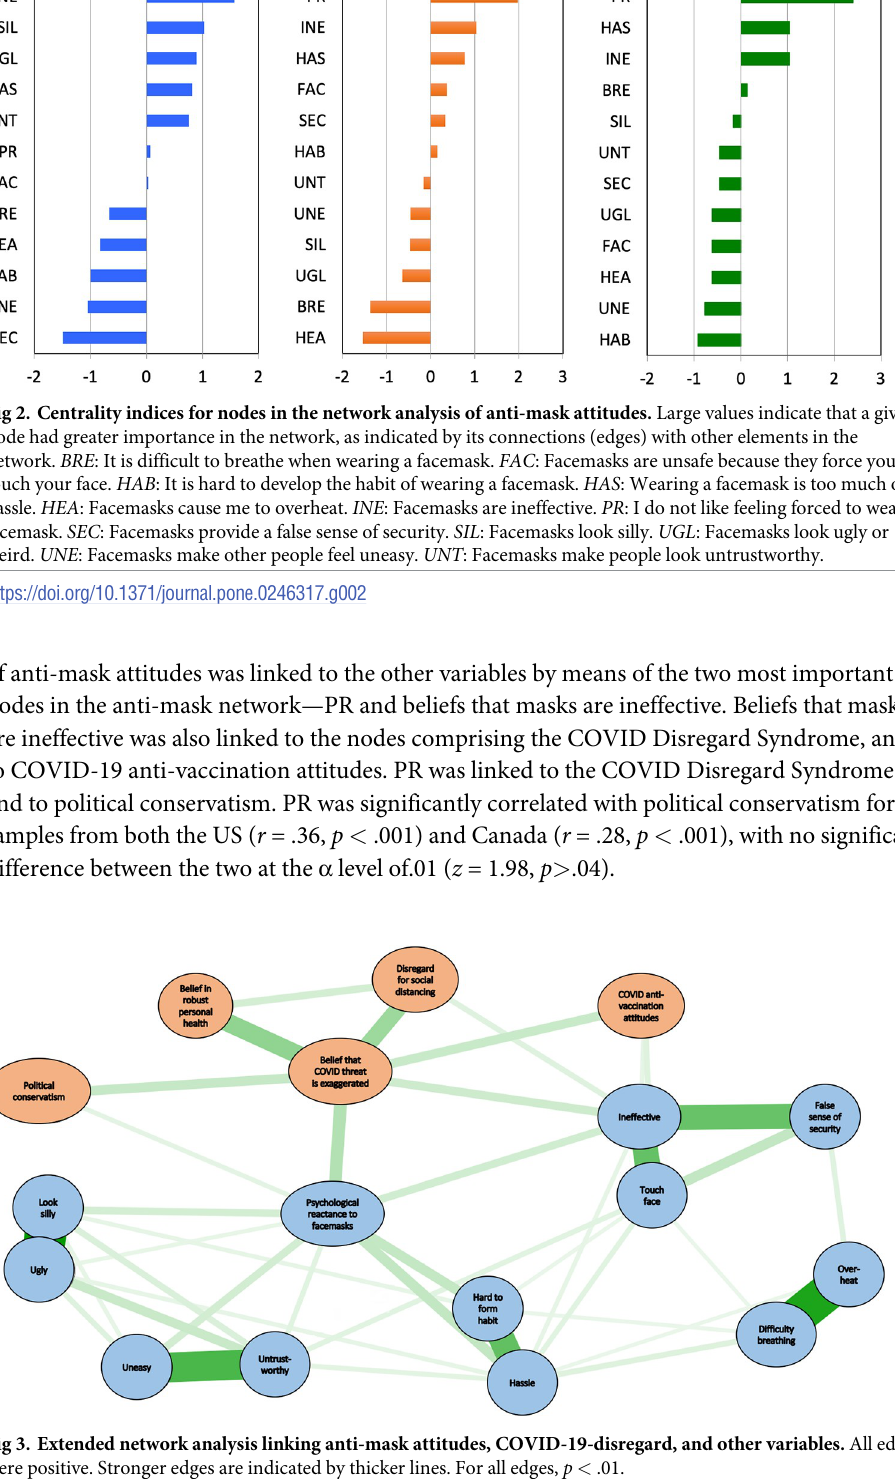
Fig 3. Extended network analysis linking anti-mask attitudes, COVID-19-disregard, and other variables. All edges were positive. Stronger edges are indicated by thicker lines. For all edges, p < .01.